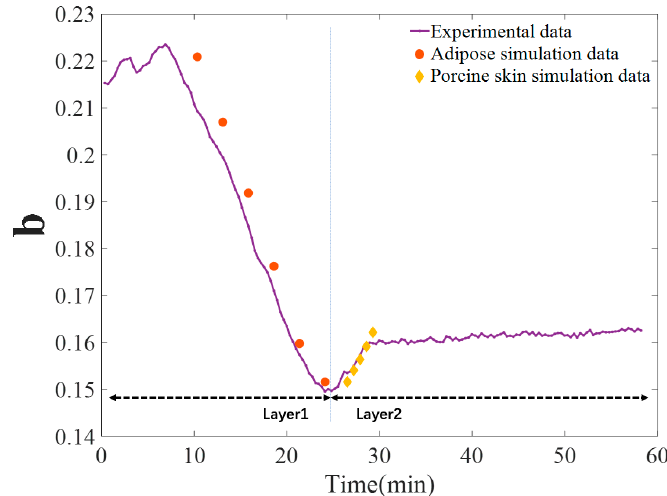
Figure 9. Average values of MMT parameter b and the result of MC simulations for double-layer tissue. Layer1: refractive index of the interstitial mass from 1.35 with 0.01 as an interval to 1.40. Layer2: refractive index of the interstitial mass from 1.35 with 0.01 as an interval to 1.39.